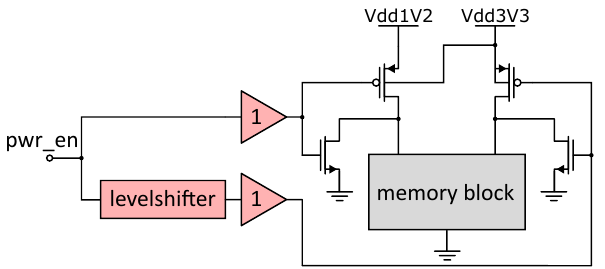
Figure 6. Implementation of the power control to reduce leakage